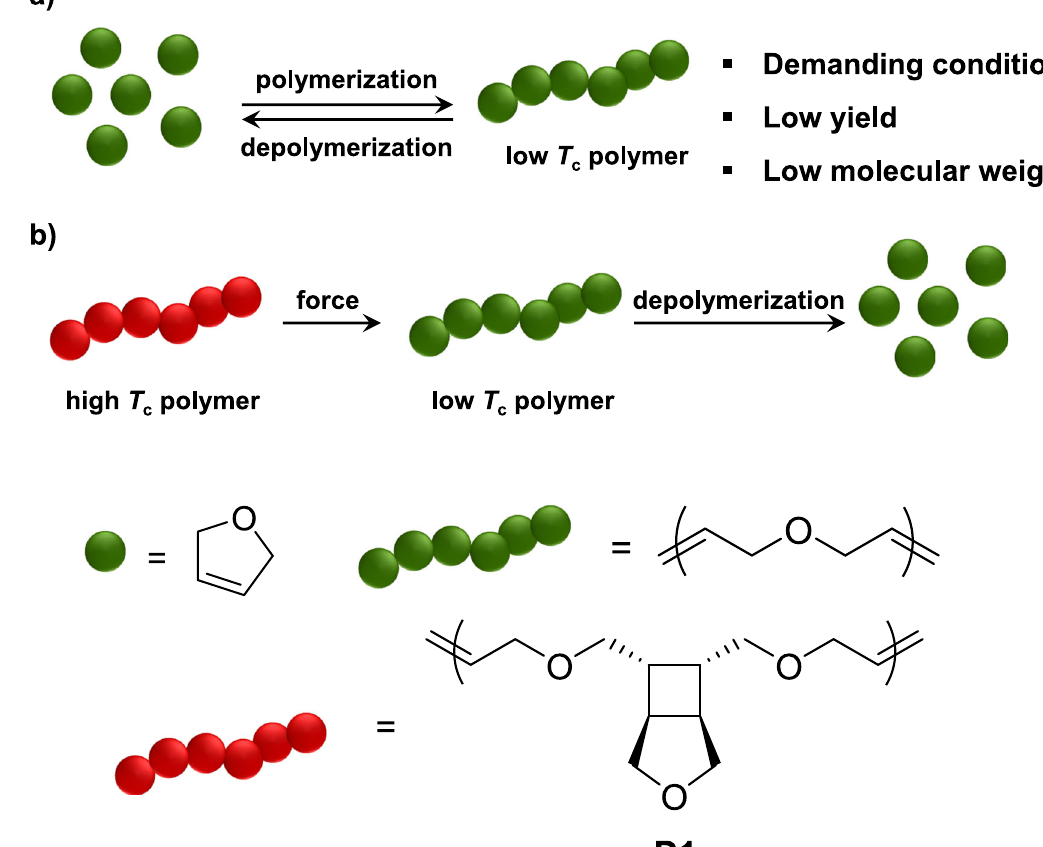
Fig. 1 | Comparison between a polymer with low ceiling temperature ( T c ) and thiswork.a Polymerizationoflow- T c polymerrequiresdemandingconditionsand suffers from low yield and low molecular weight. b A high- T c polymer is